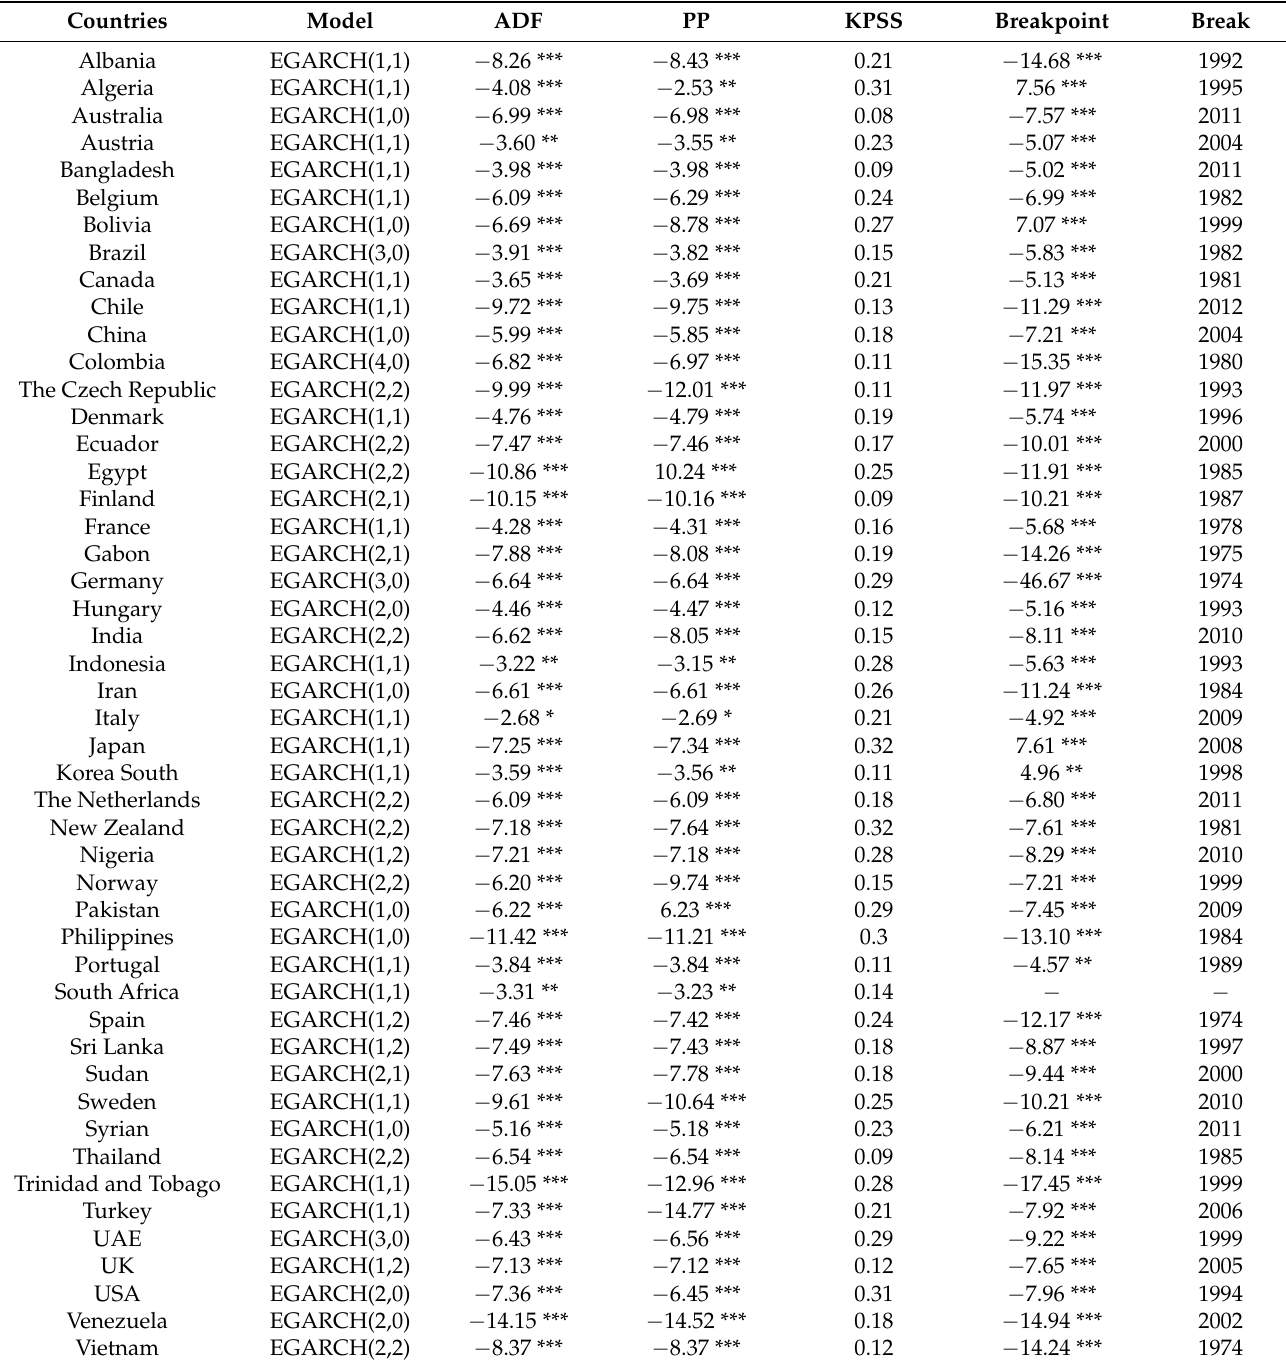
Table A4. Unit root test—energy consumption